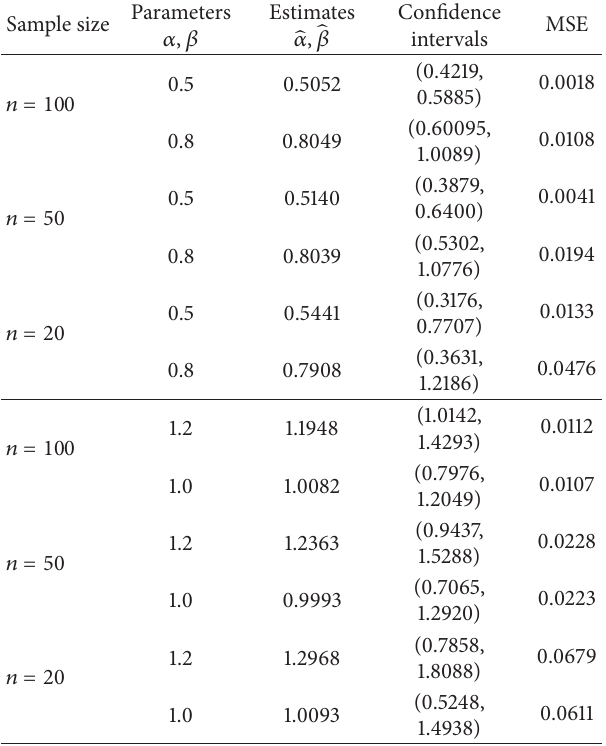
Table 2: Confidence interval for the parameters. Parameters Sample size 𝛼, 𝛽